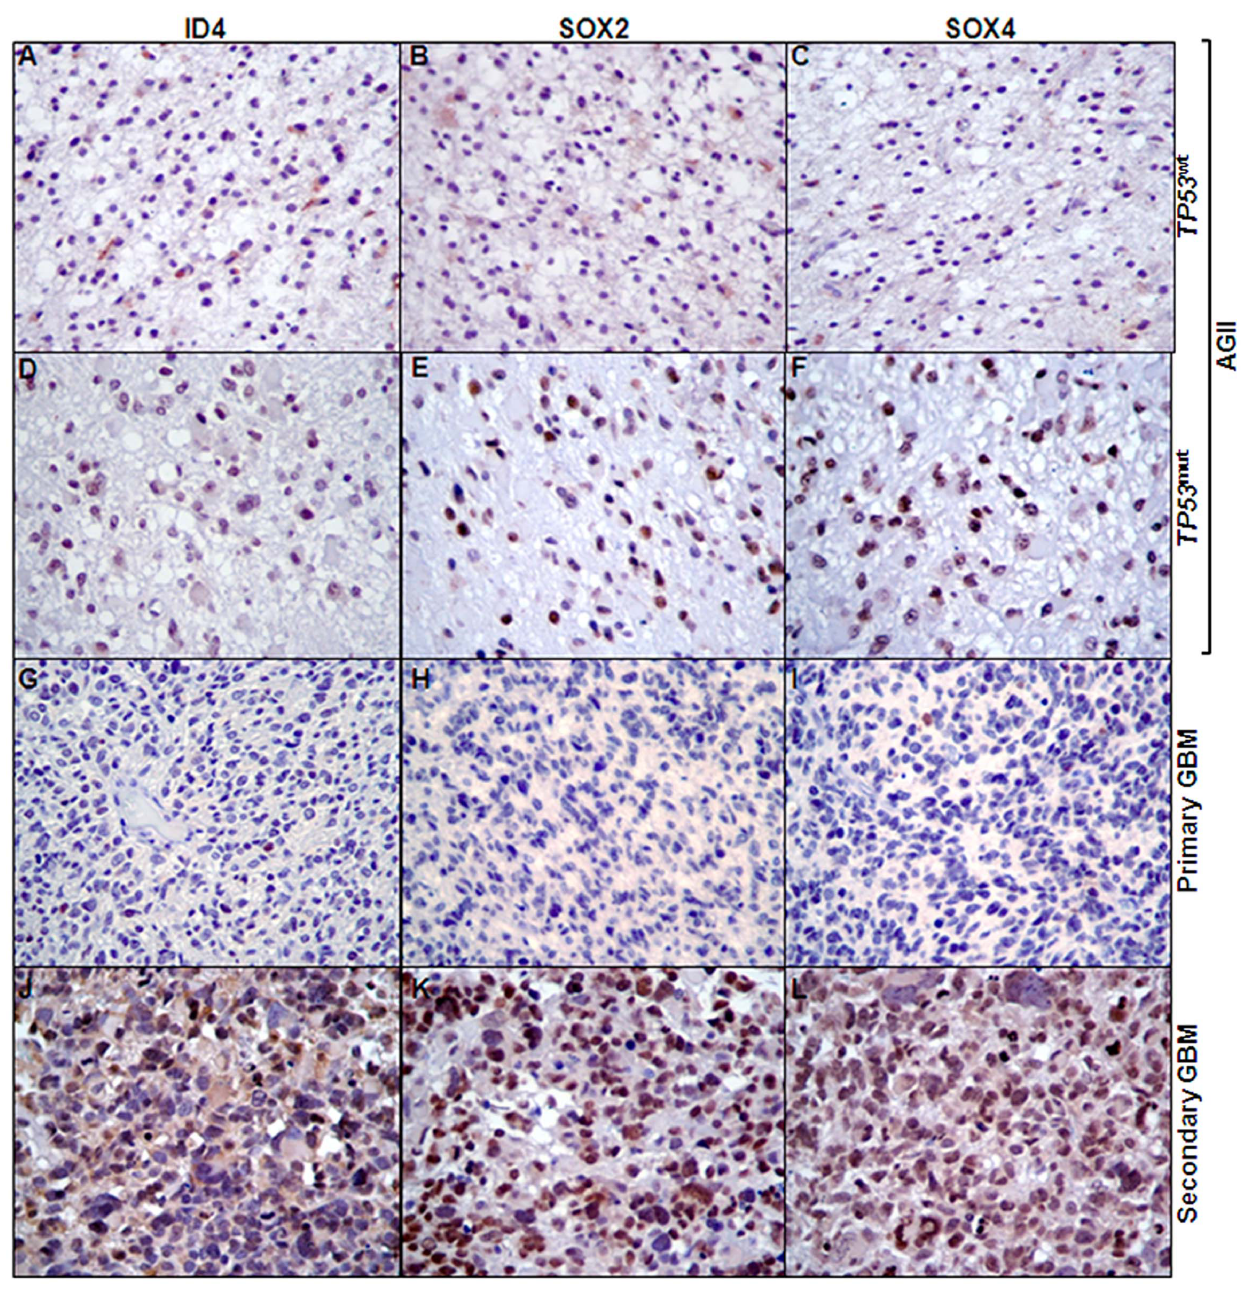
Figure 4. ID4, SOX2 and SOX4 immunohistochemistry. Representative cases of wild-type TP53 AGII (A-C), mutated TP53 AGII (D-F), primary GBM (G-I) and secondary GBM (J-L) stained for ID4, SOX2 and SOX4 are demonstrated. Both mutated AGII and secondary GBM cases showed stronger and larger number of nuclear stained cells (score 3 for intensity and $ 75% of positive cells) for ID4, SOX2 and SOX4. Comparatively, wild-type TP53 AGII and primary GBM presented score 1 for intensity and , 25% of positive cells. The reaction was performed in paraffin embeded tissue sections with a commercial polymer kit (Novolink; Novocastra, UK), using diaminobenzidine as developer and Harris hematoxylin for nuclear counterstaining. 200 6 magnification for all